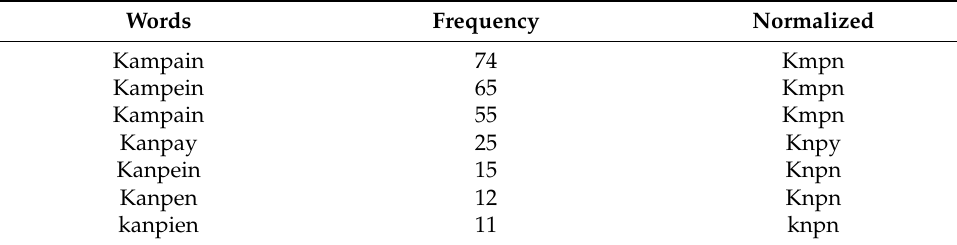
Table 7. Words normalization using proposed lexical unification